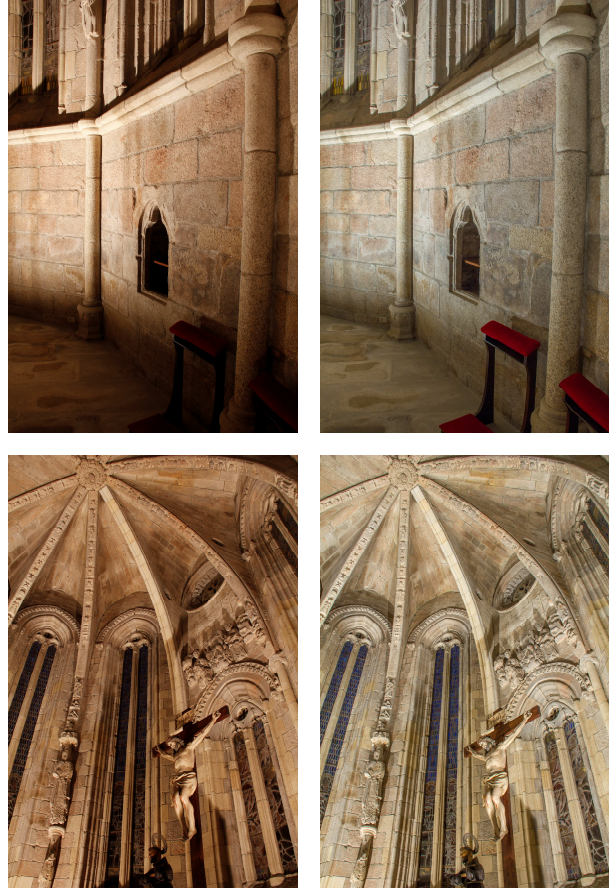
Figure 5. RAW development example.